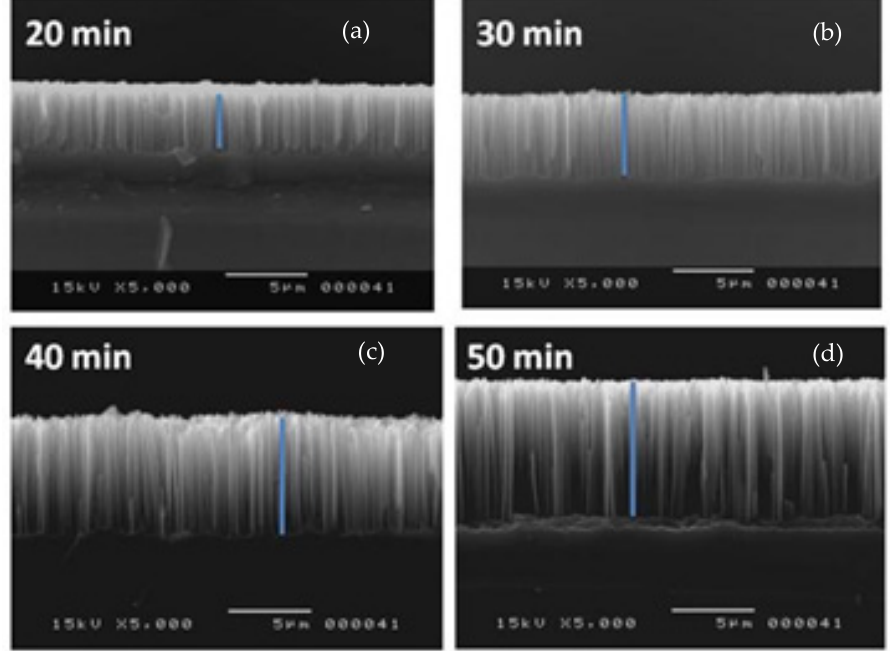
Figure 3. Cross-sectional SEM images showing SiNWs on which 30 nm PbS films were deposited for different etching times ( a ) 20 min, ( b ) 30 min, ( c ) 40 min, ( d ) 50 min.